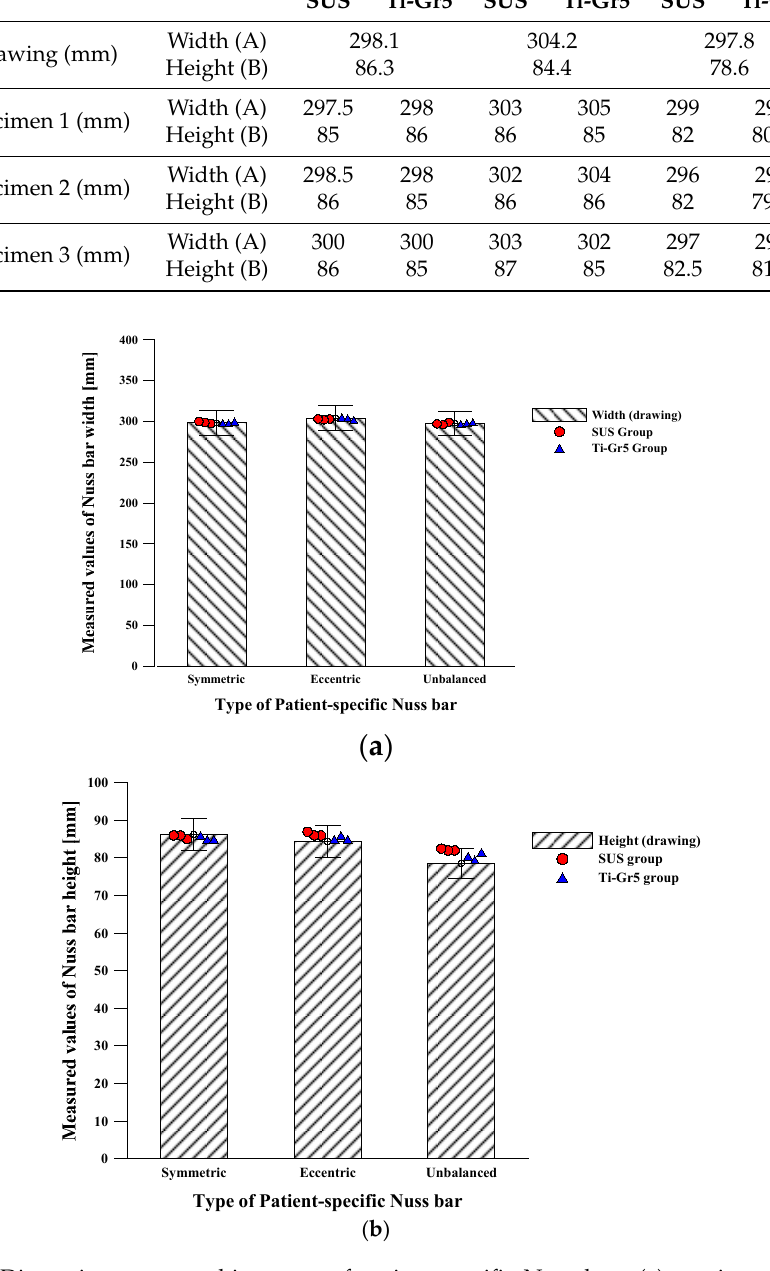
Figure 21. Dimension accuracy histogram of patient-specific Nuss bar: ( a ) maximum width of patient-specific Nuss bars was measured after Nuss bar processing and compared with original value; ( b ) maximum height of patient-specific Nuss bars was measured and compared with original data.